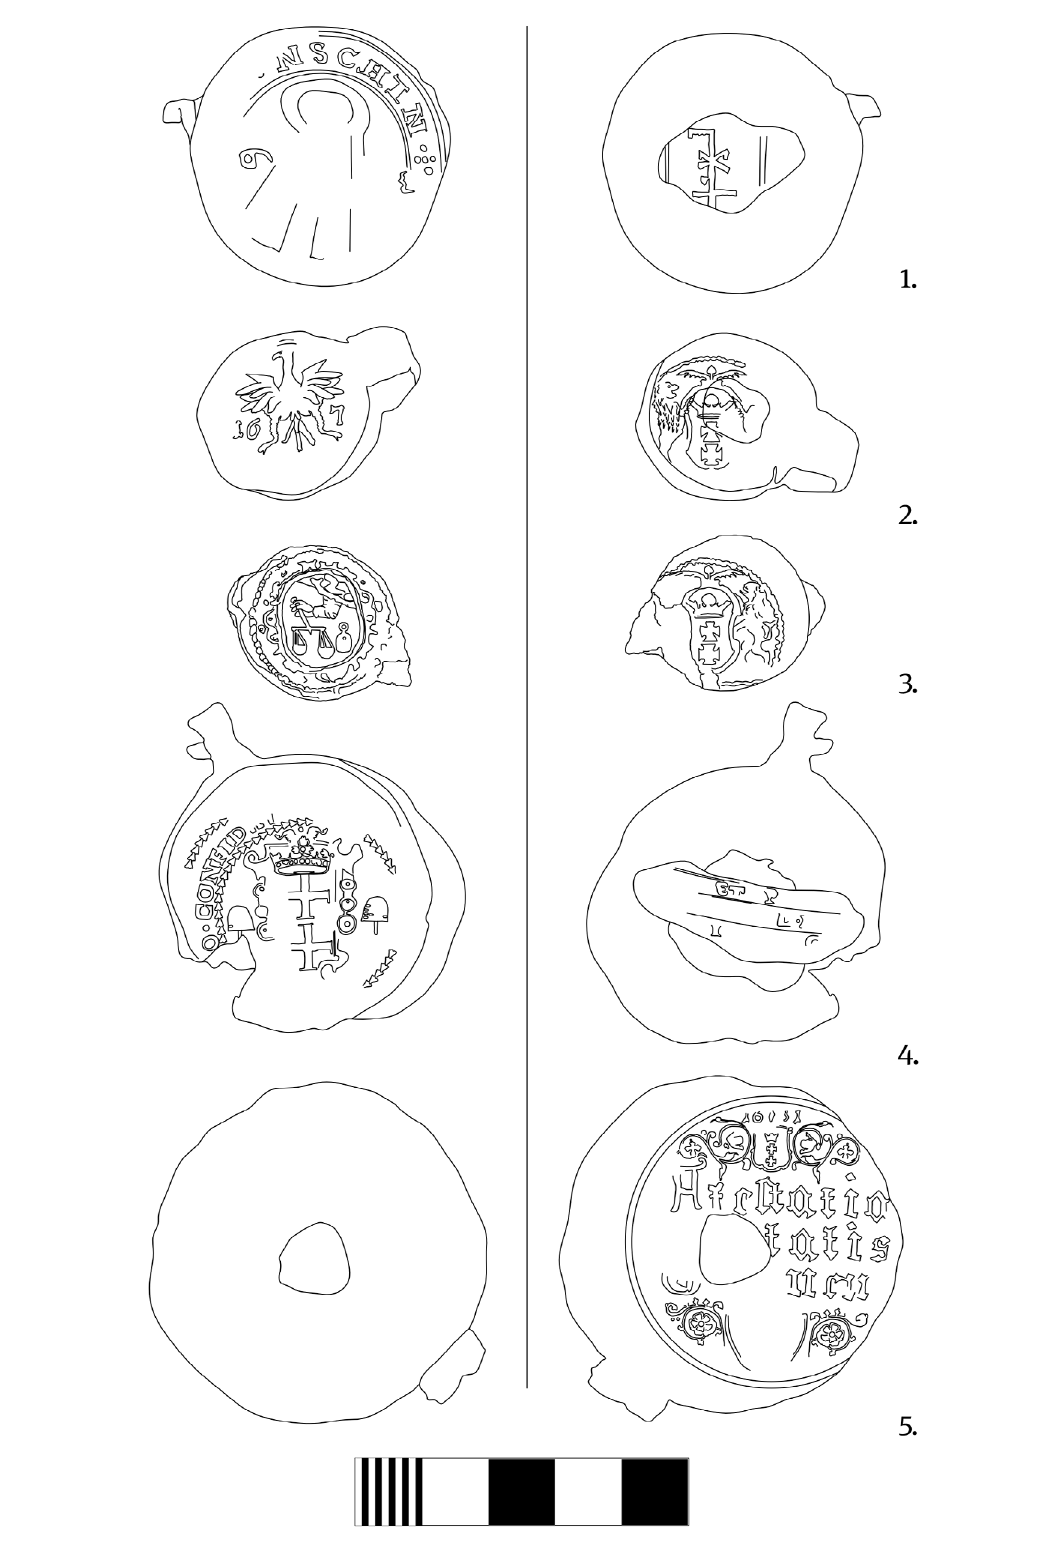
Figure 27. Lead seals originated from Zbąszyń (1), Gdańsk